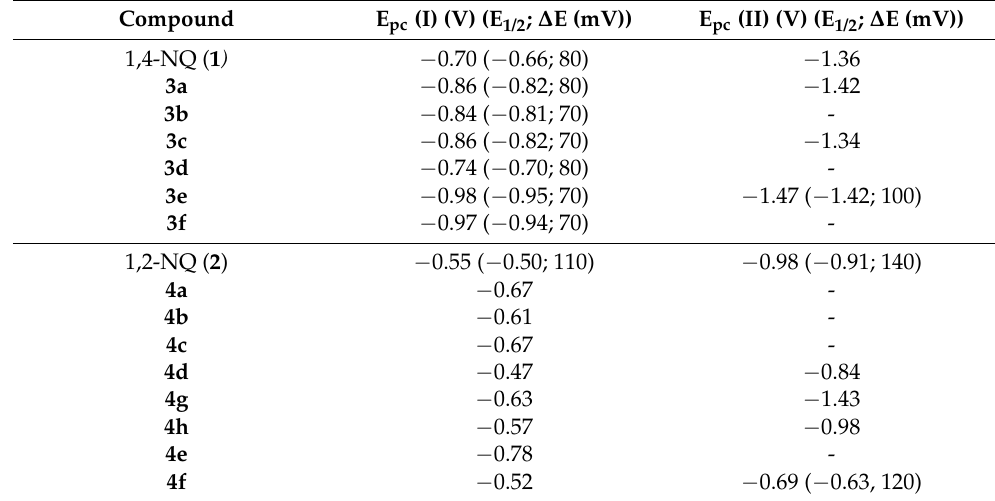
Table 3. Selected electrochemical data in acetonitrile (scan rate: 0.100 V · s − 1 ).